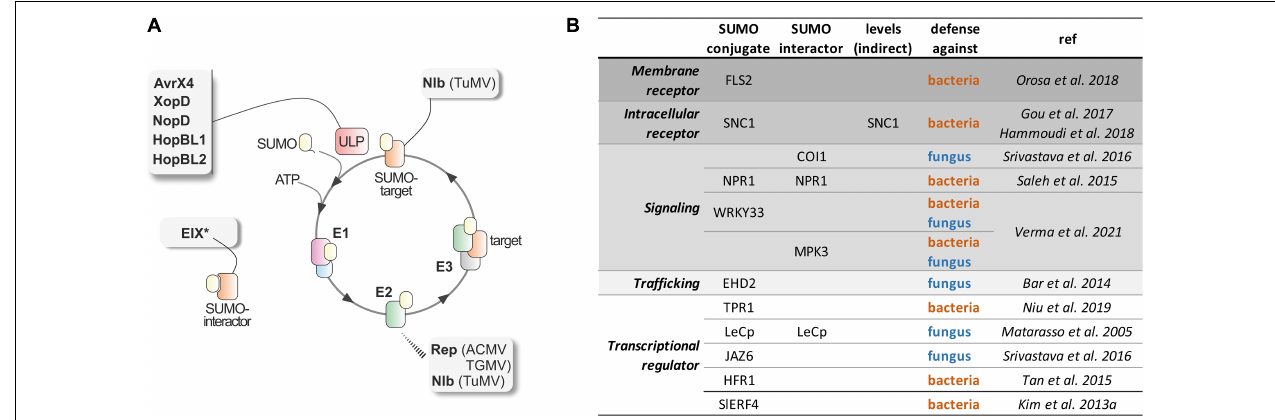
FIGURE 1 | SUMOylation in Plant Defense. (A) SUMO conjugation/deconjugation cycle: SUMO is synthesized as a precursor that is processed at its C-terminal tail by the specific ULP proteases, releasing a SUMO mature form with a Gly–Gly motif at its C-terminus. Subsequently, SUMO is activated by the heterodimeric E1 activating enzyme, SAE1/SAE2, transferred to the E2 conjugating enzyme, and, finally, attached to a target lysine in the substrate. The target lysine is usually located within the consensus site (cid:57) KxE/D ( (cid:57) is a large hydrophobic amino acid, and x, any amino acid). This final step is facilitated by E3 ligase enzymes that interact with both SUMO-charged E2 and the substrate. SUMOylation is a reversible modification, and the same class of cysteine proteases involved in the maturation step catalyze SUMO excision from the substrate. Identified pathogen effectors establish distinct interactions with the plant SUMO machinery components. The viral proteins Rep and Nlb interact with the E2 conjugating enzyme. In addition, Nlb is also modified by SUMO3. The most abundant are bacterial effectors that display SUMO protease activity (AvrX4, XopD, NopD, HopBL1, and HopBL2). And the non-covalent interactions between the extracellular fungal MAMP EIX and tomato SUMO (the asterisk denotes that is an extracellular effector). (B) List of plant defense proteins shown to be regulated by SUMOylation. The molecular role of SUMO is indicated as SUMO conjugate, SUMO interactor or protein levels modulation by an indirect mechanism, such as regulation of mRNA